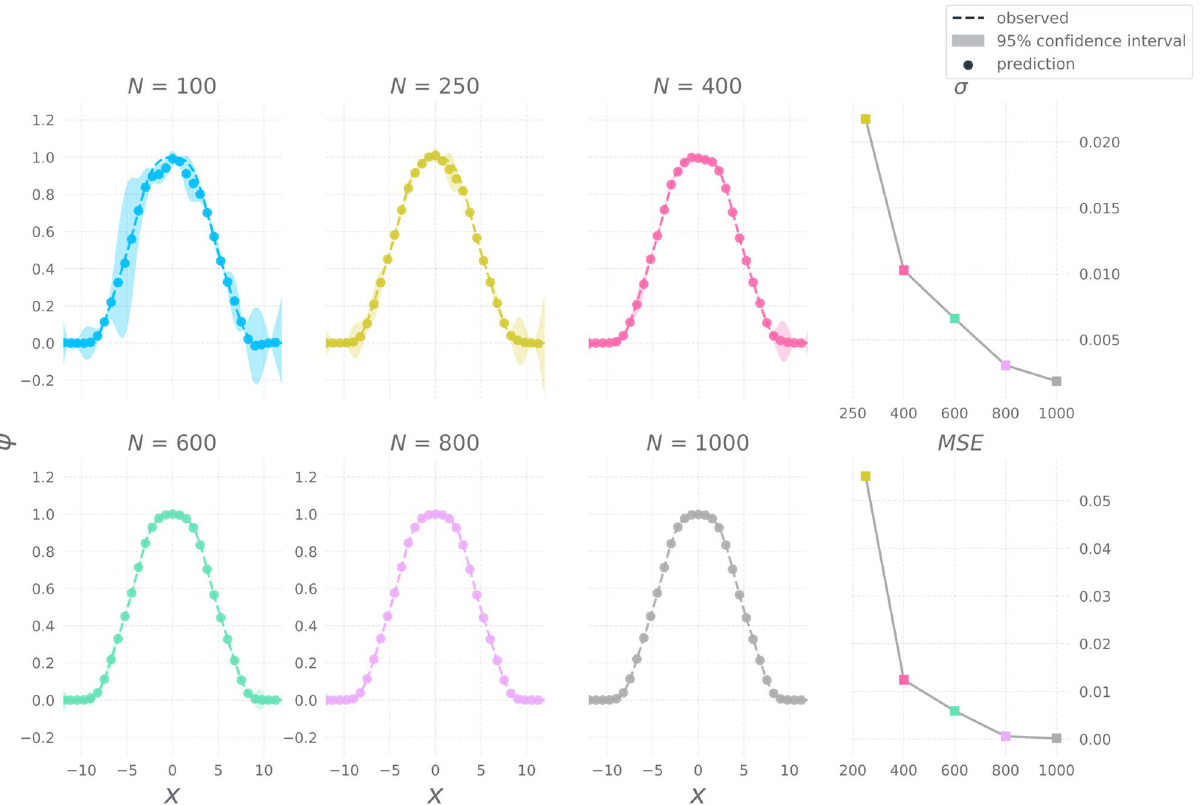
Figure 3. Gaussian Processes fit on training samples of different sizes, N = { 100, 250, 400, 600, 800, 1000 } Variance σ and Mean-squared Error (MSE) plotted against training sample size.